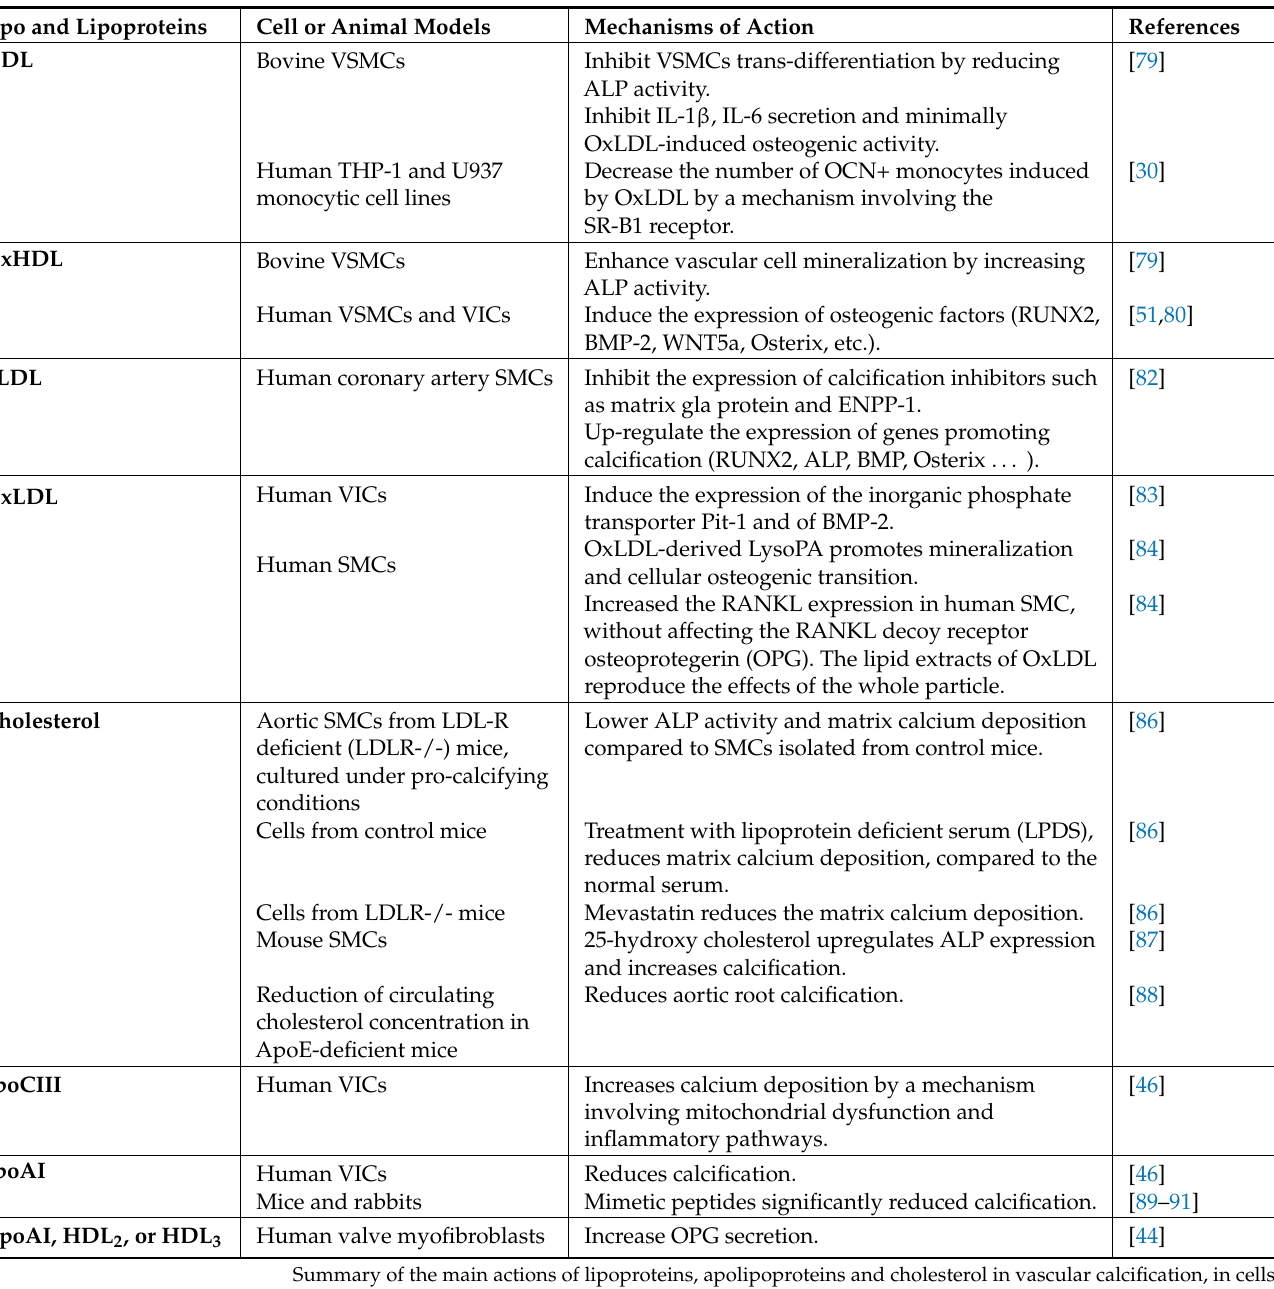
Table 1. Mechanisms of action of lipoproteins and apolipoproteins in vascular